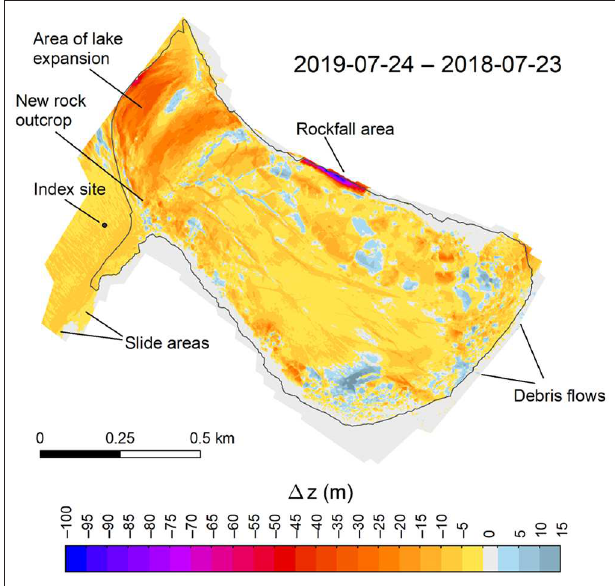
FIGURE 16 | Elevation changes at Suicide Basin between 23 July 2018 and 24 July 2019. The differenced DEMs represent post-GLOF conditions, with similar water levels in the basin (386 m in 2018 and 383 m in 2019). The colormap features a 5 m color spacing, except for the ± 1 m interval, which features a light gray tone. The black line delineates the maximum lake extent in